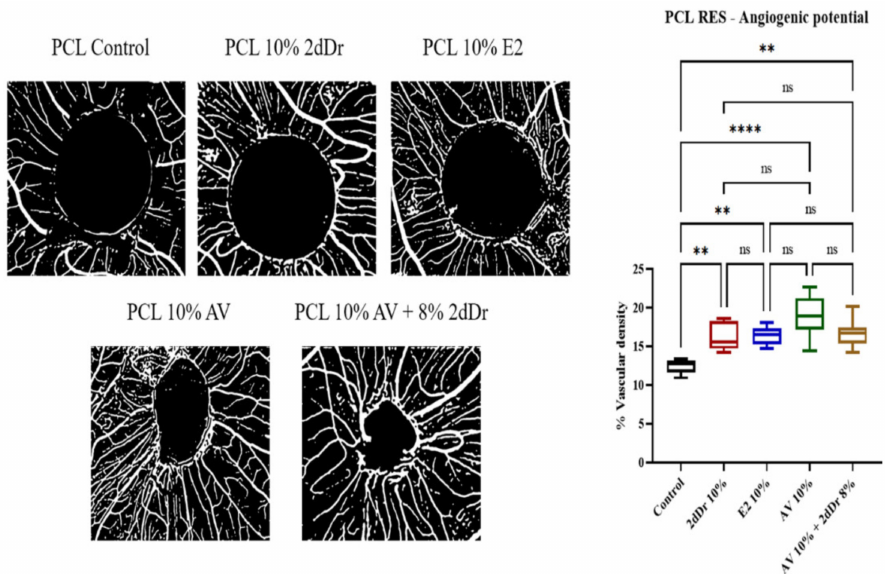
Figure 8. Evaluation of angiogenic potential for PCL scaffolds loaded with bioactive compounds. Negative images of the vessel formation (left) and the % vascular density (right) for each bioactive compound and combination tested are shown. ns = no significance, ** p < 0.01, **** p < 0.0001. N = 2, n =